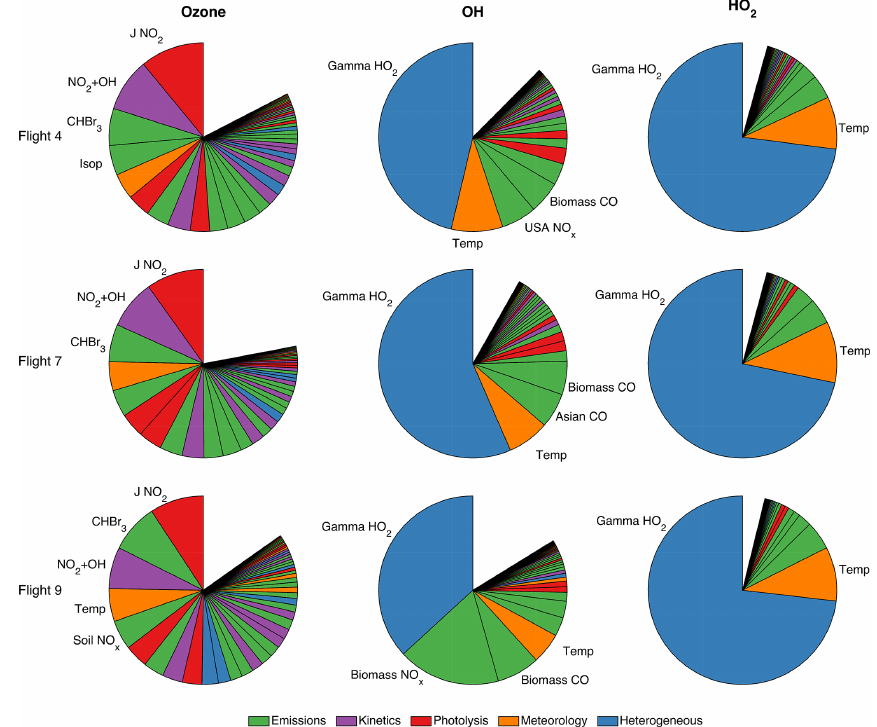
Figure 3. First-order sensitivity indices for average flight track O 3 , OH, and HO 2 for ARCTAS-A flights. Legend categories are defined